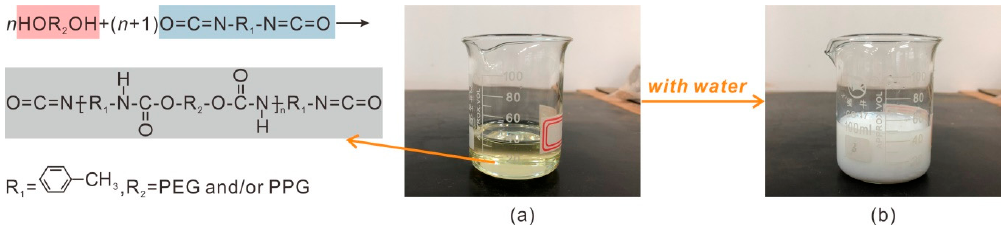
Figure 2. The photographs of (a) organic polymer and (b) hydrogel.